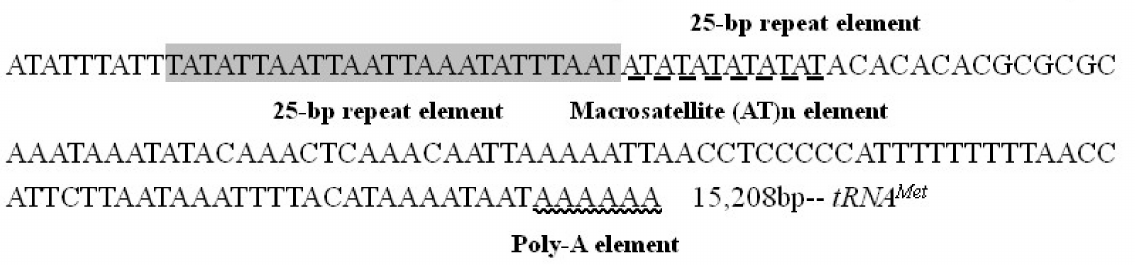
Figure 9. The control region in Hestinalis nama